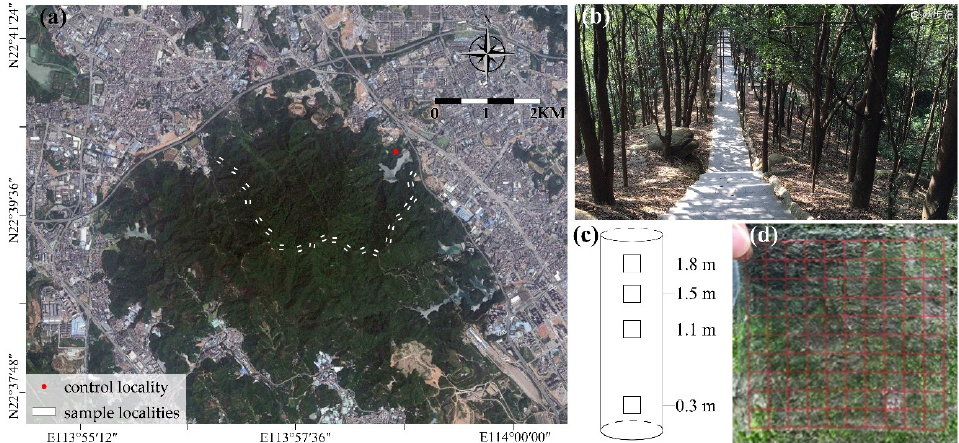
Figure 1. Visual summary of the sampling design at the different scales. ( a ) Map showing the 42 sample localities and 1 control locality. (b ) Image of the Schima superba forest in the study. ( c ) Sampling positions on each tree trunk. ( d ) Sampling area (subplot) measurements of each tree using grid squares (10 × 10 cm).